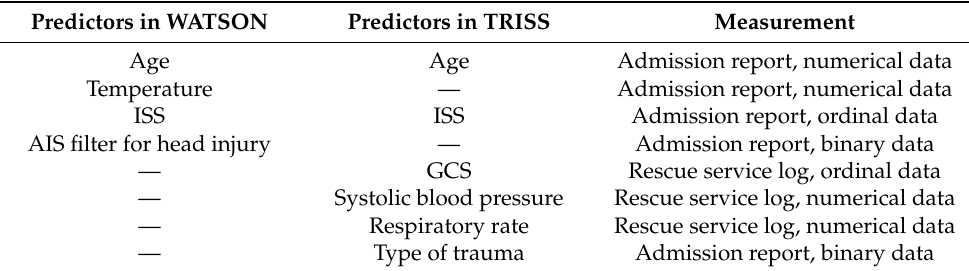
Table 1. Predictors used in WATSON and